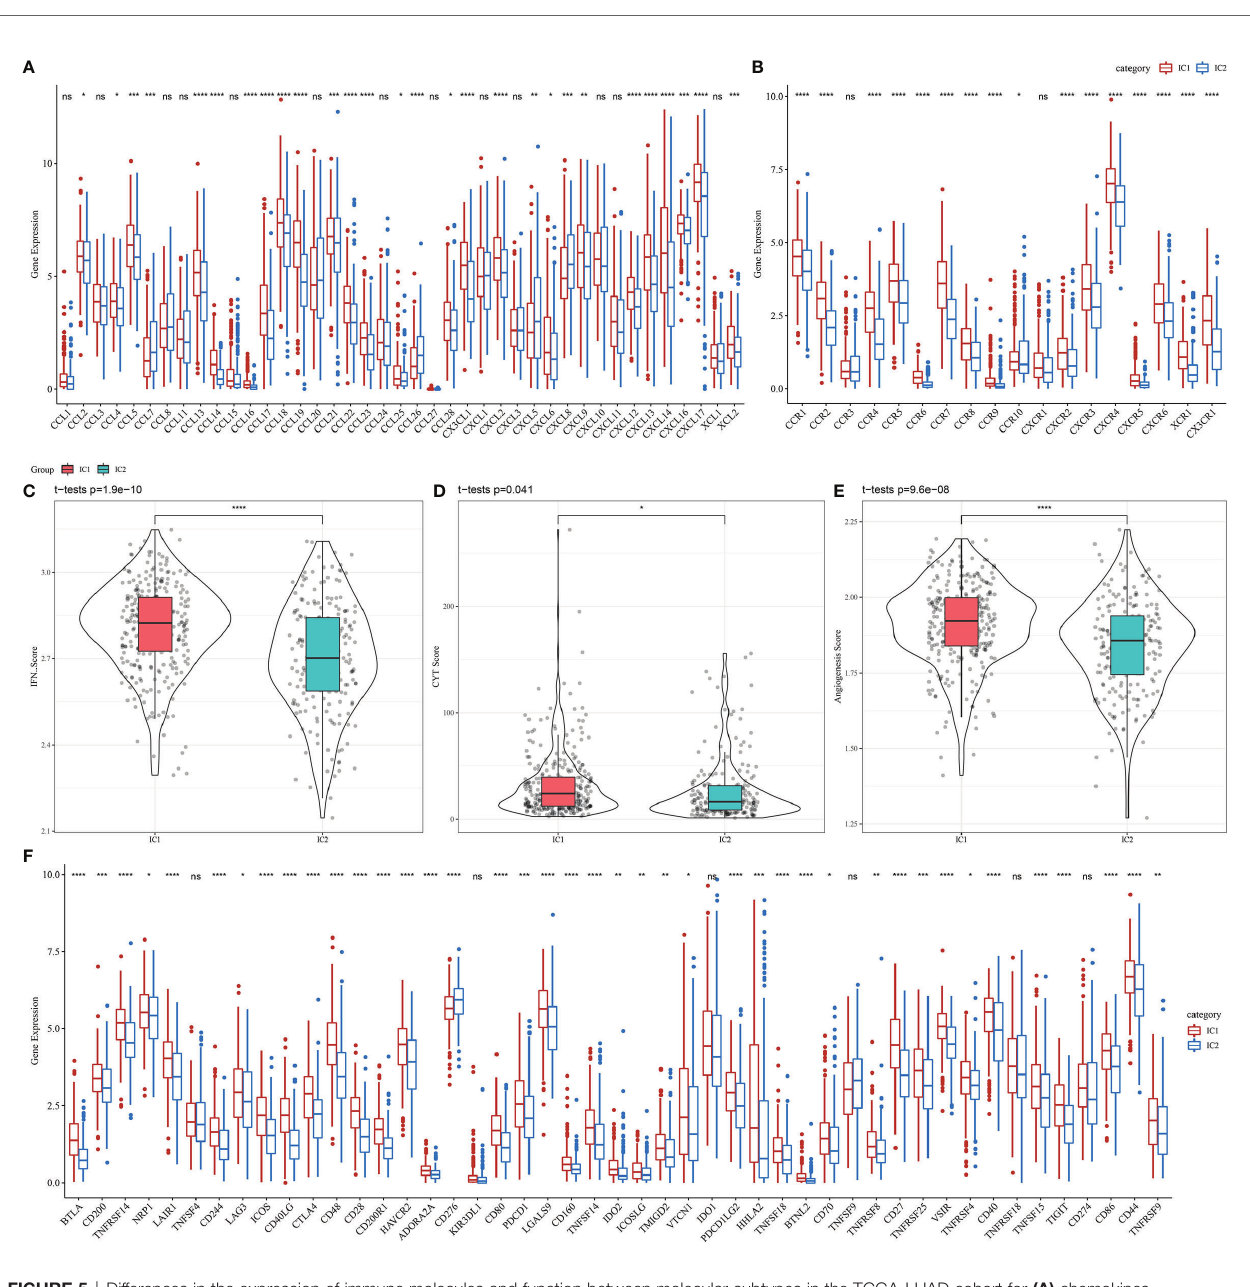
FIGURE 5 | Differences in the expression of immune molecules and function between molecular subtypes in the TCGA-LUAD cohort for (A) chemokines, (B) chemokine receptors, (C) IFN g , (D) immune T cell lysis activity, (E) angiogenesis scores, and (F) immune checkpoint genes. Signi fi cance was determined using ANOVA, where *p < 0.05; **p < 0.01, ***p < 0.001, ****p < 0.0001. ns, no signi fi